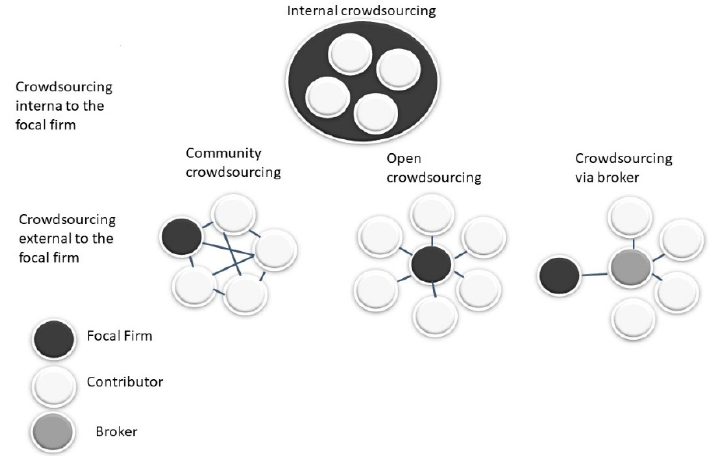
Figure 1. Categorization of configurations for innovation crowdsourcing (adopted from [16]).